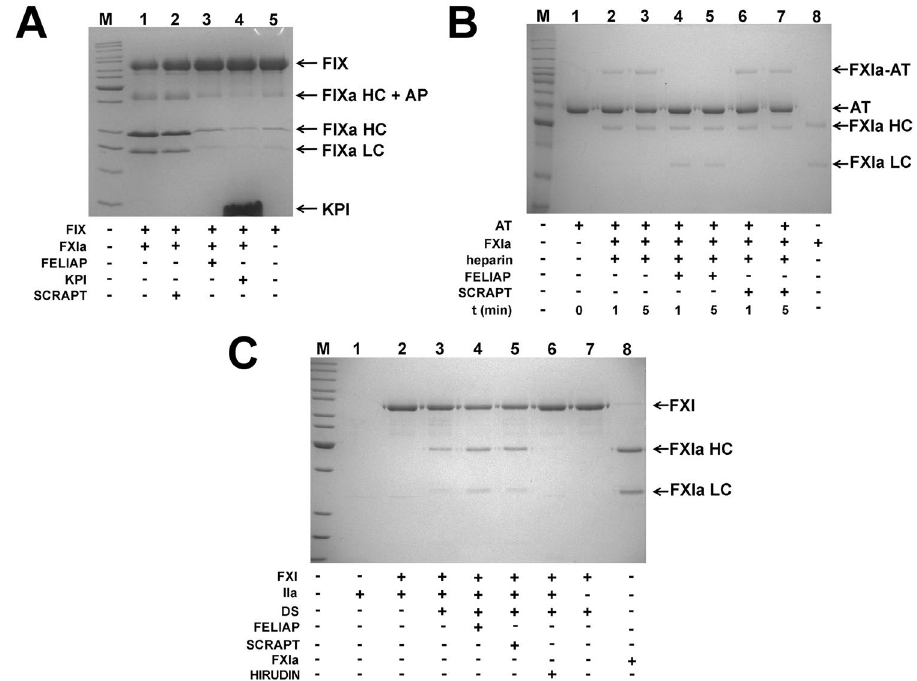
Figure 4. Effects of FELIAP on reactions of FXIa and FXI with macromolecular substrates. ( A ) Coomassie- stained reduced SDS-polyacrylamide gel. FIX was reacted with FXIa in the presence ( + ) or absence ( − ) of SCRAPT (lane 2), FELIAP (lane 3) or KPI (lane 4). Arrows and labels, at right, identify the position of FIX, forms of FIXa (including HC, heavy chain, HC + AP, heavy chain + activation peptide intermediate, LC, light chain) and KPI. M, markers (kDa), at left: 220; 160; 120; 100; 90; 80; 70; 60; 50; 40; 30; 25; 20; 15. ( B ) As in A, except antithrombin (AT, lane 1) was reacted with FXIa (lane 8) in the presence of heparin for 1 (lane 2) or 5 (lane 3) minutes with FELIAP (lanes 4 and 5) or SCRAPT (lanes 6 and 7) or no DNA addition (lanes 2 and 3). Arrows and labels identify the position of AT, FXIa-AT covalent complex, FXIa heavy chain (HC) and light chain (LC). M, markers (kDa), at left: 220; 160; 120; 100; 90; 80; 70; 60; 50; 40; 30; 25; 20 ( C ). As in A and B except FXI and thrombin (IIa, lane 1) were reacted in the absence (lane 2) or presence of dextran sulphate (DS, lanes 3–7) with the addition of FELIAP (lane 4) or SCRAPT (lane 5) or the thrombin inhibitor hirudin (lane 7). Lane 8, purified FXIa. M, markers (kDa), at left: 220; 160; 120; 100; 90; 80; 70; 60; 50; 40; 30; 25; 20;